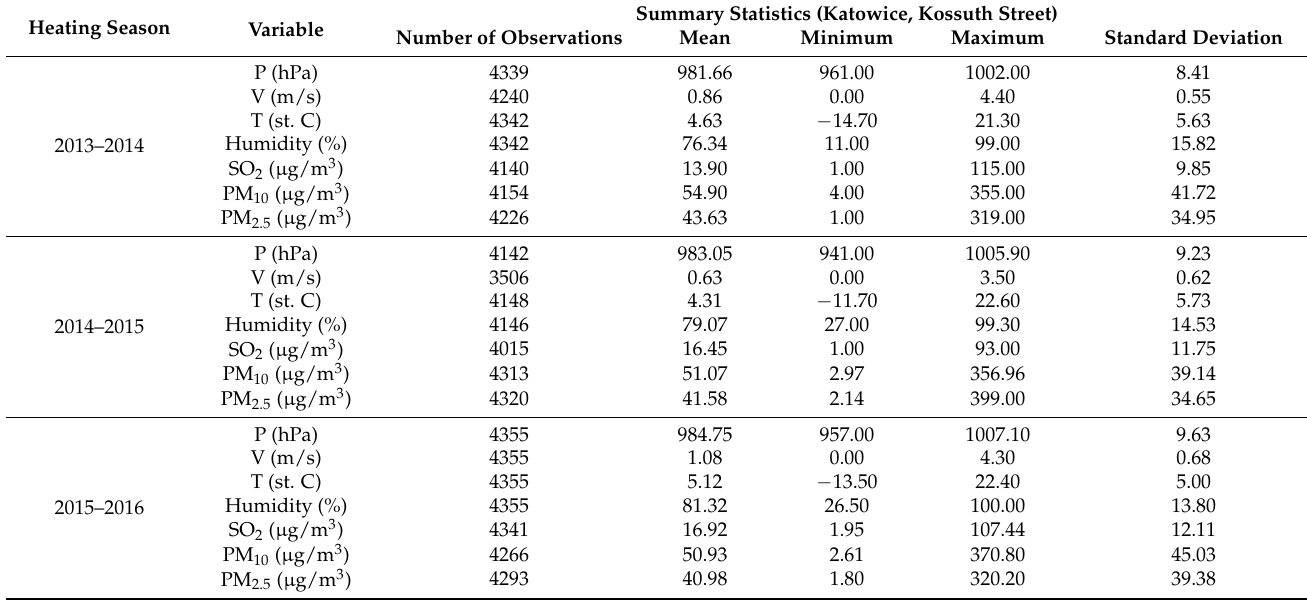
Table 4. Summary statistics for data in individual seasons.